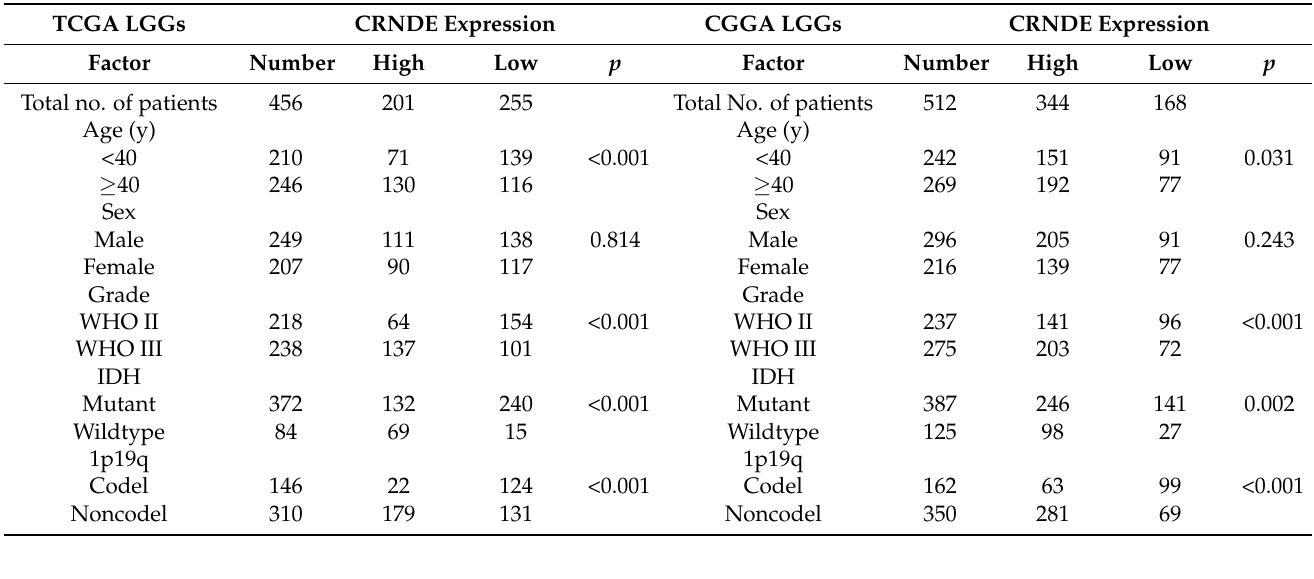
Table 1. Characteristics of LGG patients in the training and validation sets.